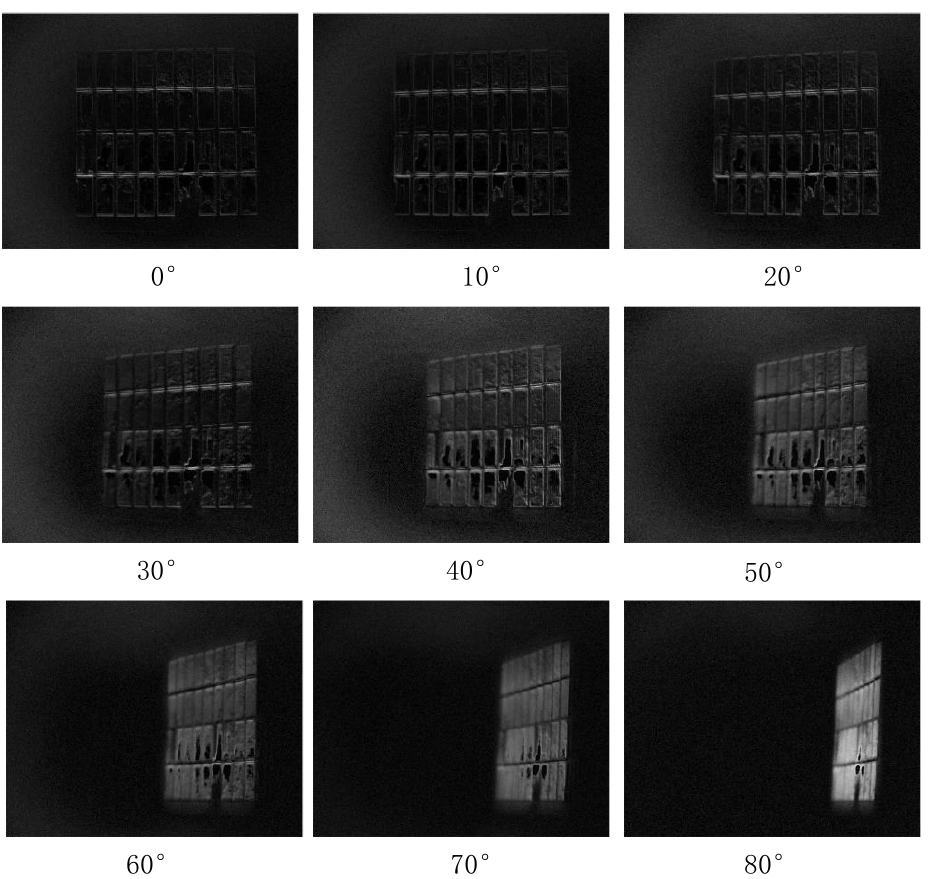
Figure 11. DOP images at different view angles under 12 V external positive bias voltage.